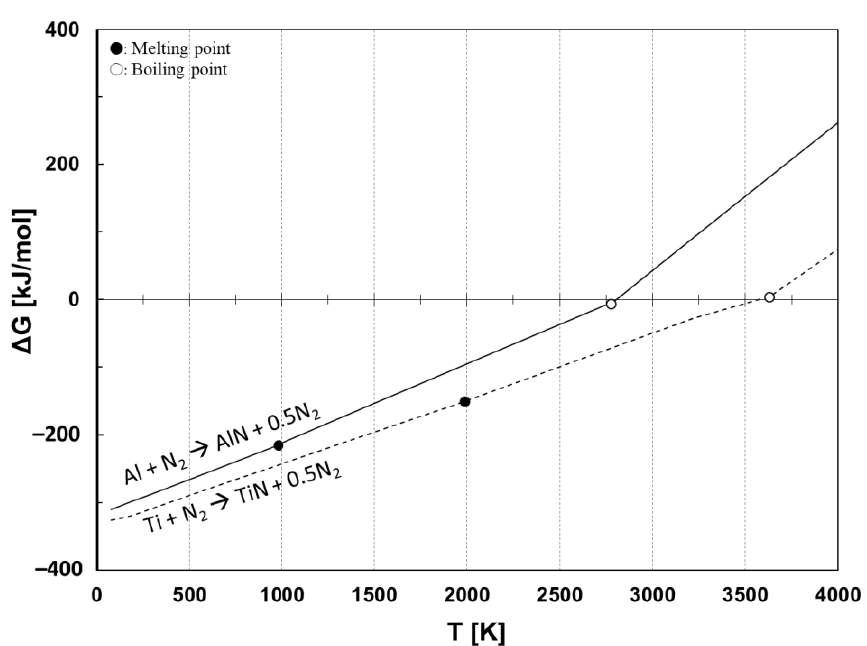
Figure 1 . Gibbs standard free energy for synthesizing nitrides from Ti and Al electrodes. Figure 1. Gibbs standard free energy for synthesizing nitrides from Ti and Al